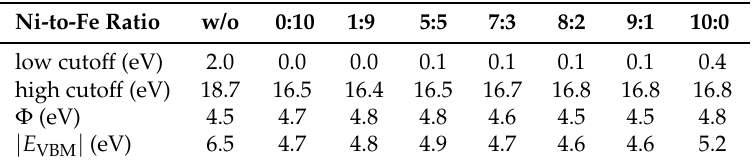
Figure 7. ( a ) ultraviolet photoelectron spectroscopy (UPS) spectra of the bare hematite and the Ni x Fe 1 − x O y electrocatalysts on hematite with various Ni-to-Fe ratios of the precursor. The immersion time for depositing Ni x Fe 1 − x O y was 2 min; ( b ) magnified view of the low binding-energy cutoff region. Table 2. Energies of the Fermi levels ( E F ) and the valence band maxima ( E VBM ) retrieved from ultraviolet photoelectron spectroscopy (UPS) spectra shown in Figure 7. The work function ( Φ ) gives the energy of the Fermi level with respect to the vacuum level and is calculated with Φ = 21.22 eV − ( E highcutoff − E lowcutoff ). | E VBM | is calculated with | E VBM | − | E F | = E lowcutoff